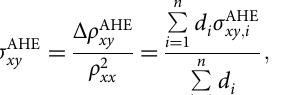
H = 55.6 mT and for Mn (Fig. 3a) measured at T = 20 K, μ 0 H = 0 T. Measurements were conducted after (Fig. 3b) at 50 K, μ 0 fi eld cooling in 280 mT in the case of Mn and, due to magnet limitations, in 55.6 mT in the case of Ir. The fi eld of 55.6 mT was high enough to saturate magnetization in either fi eld orientation (see below). XMCD measured in total electron yield (TEY) mode showed a robust magnetic moment of the Mn. XMCD spectra of the L-edge in partial fl uorescence yield (PFY) mode using L 2 and L 3 edge data at 20 K were used to obtain spin moments, which were aligned antiparallel to the Mn moment.